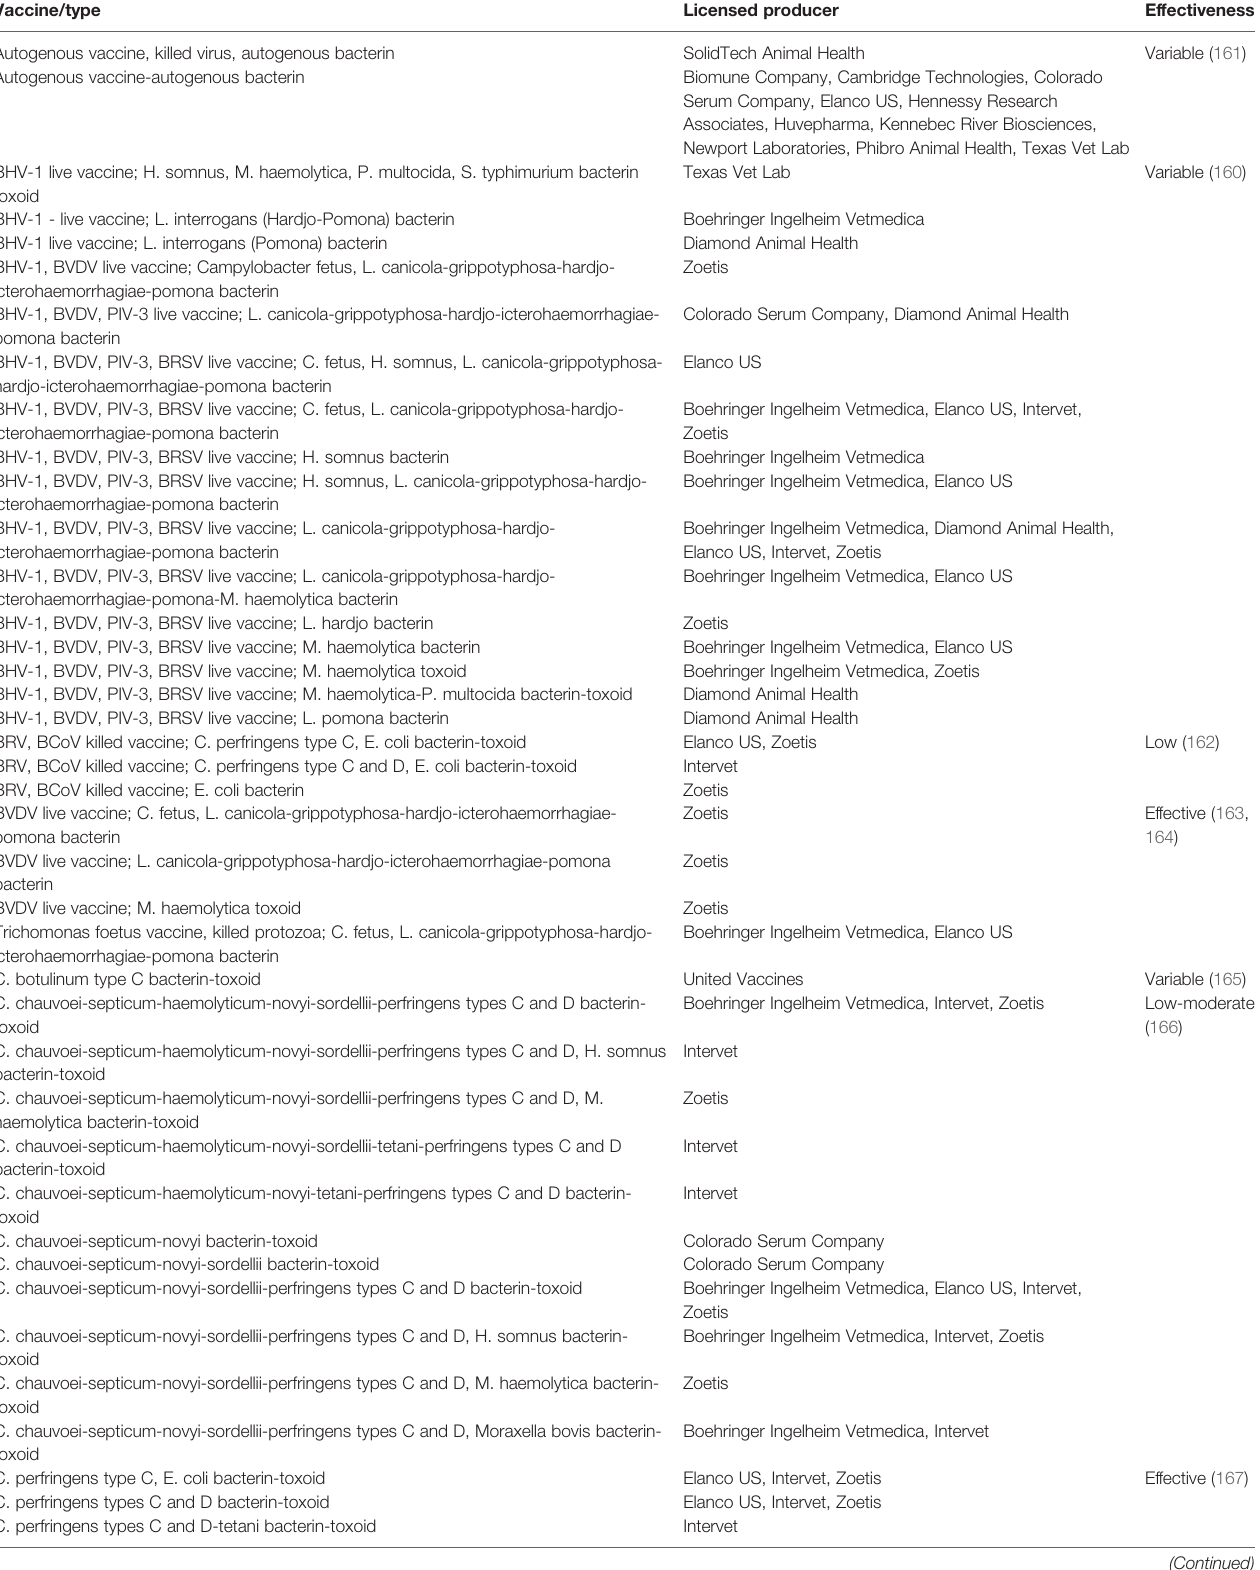
TABLE 2 | USDA licensed antiviral and antibacterial vaccines and preventative therapeutic products for